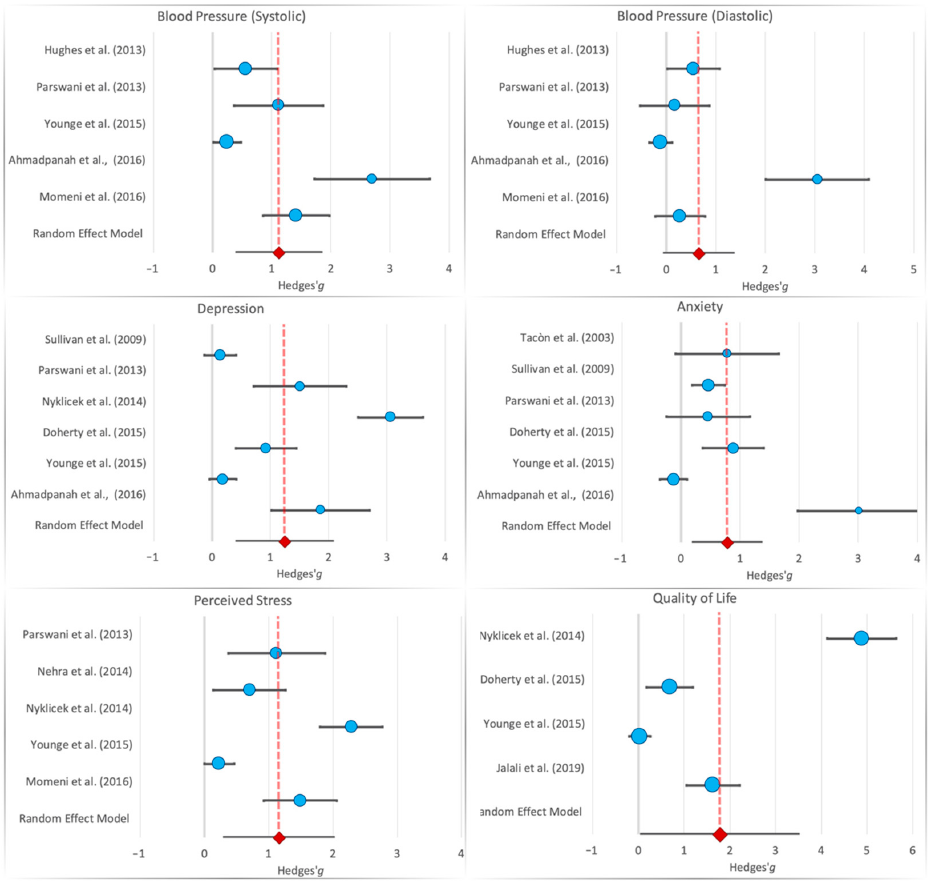
Figure 2. Forest plot for the six selected constructs. Dotted line is the Hedges’ g for the random- effects model. [9,10,17,26–28,30–33] model